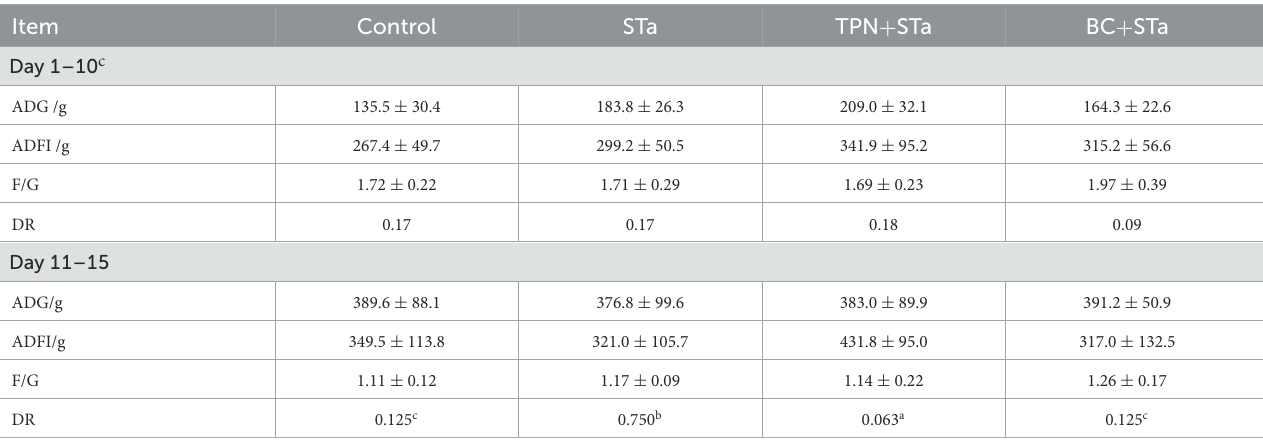
TABLE 3 Growth performance of piglets.